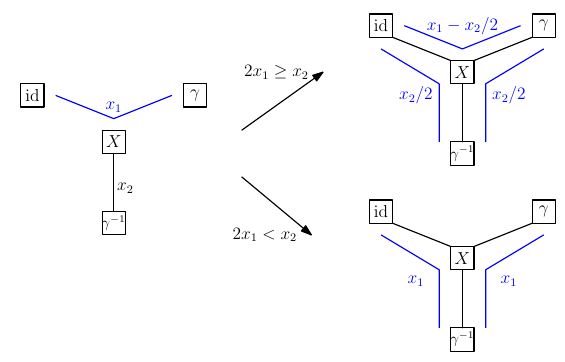
Figure 26 . Argument for absence of the